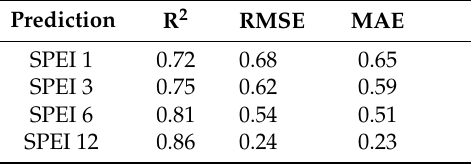
Table 4. Model performance under ANN